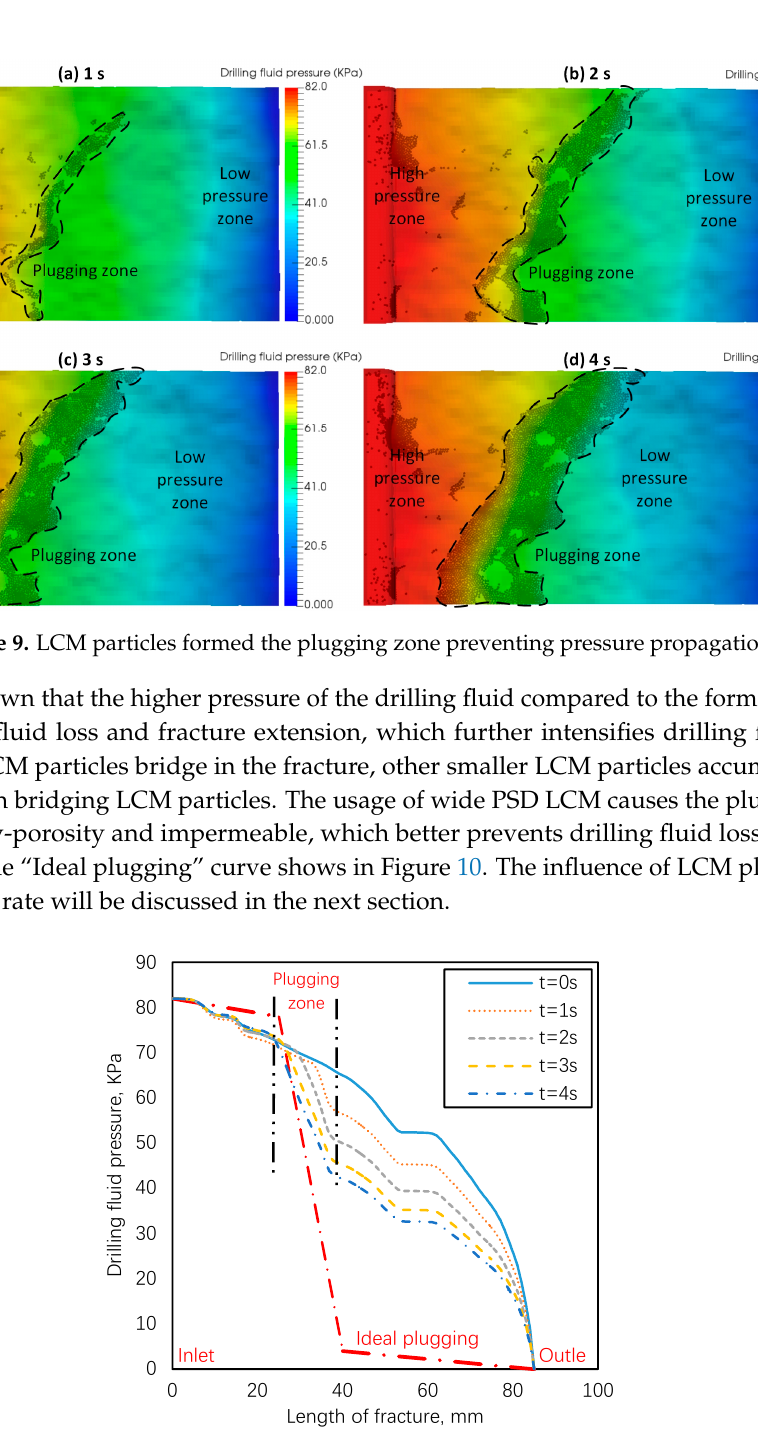
Figure 10. Drilling fluid pressure distribution of the fracture’s middle section along the length of the fracture.